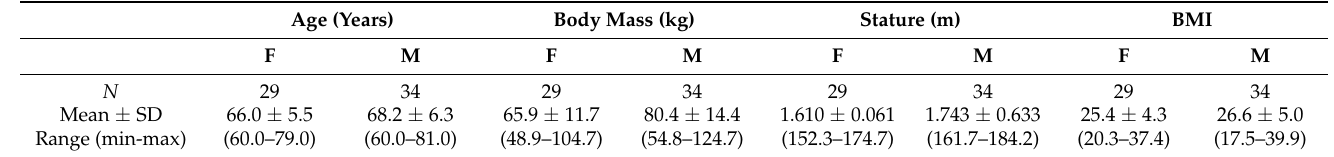
Table 1. Anthropometric characteristics of the participants ( N =